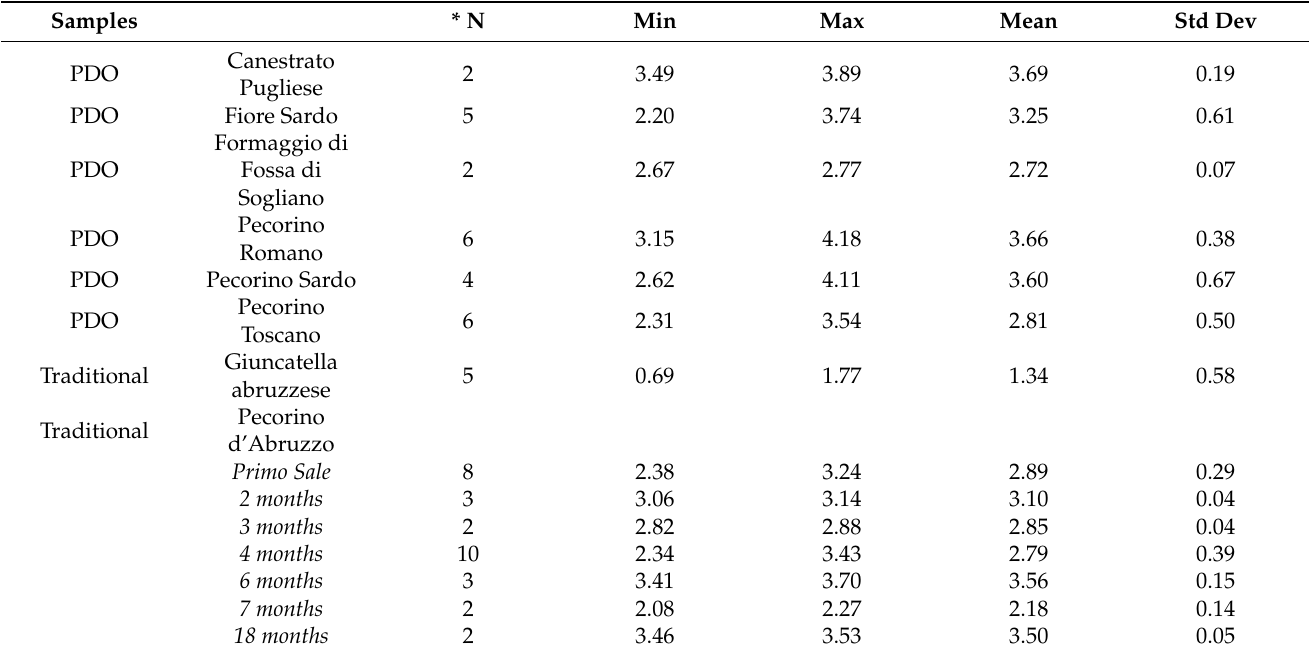
Table 2. Zinc content in PDO and Traditional Italian sheep cheeses (mg/100